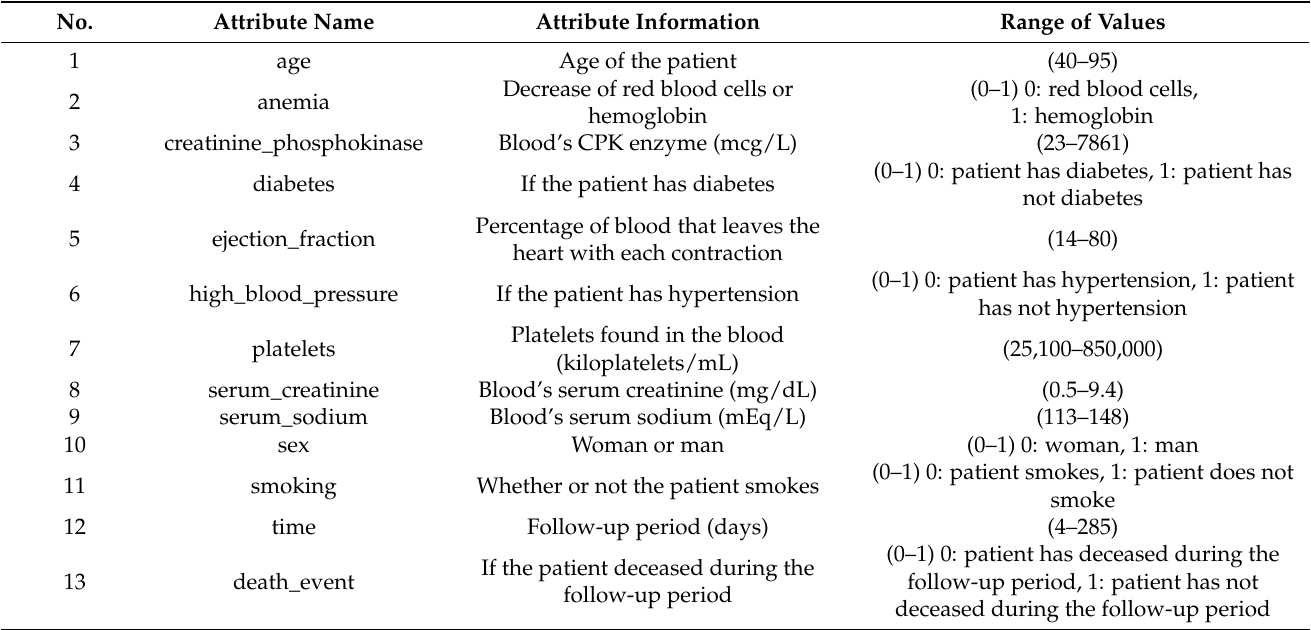
Table 3. Dataset description of heart failure.